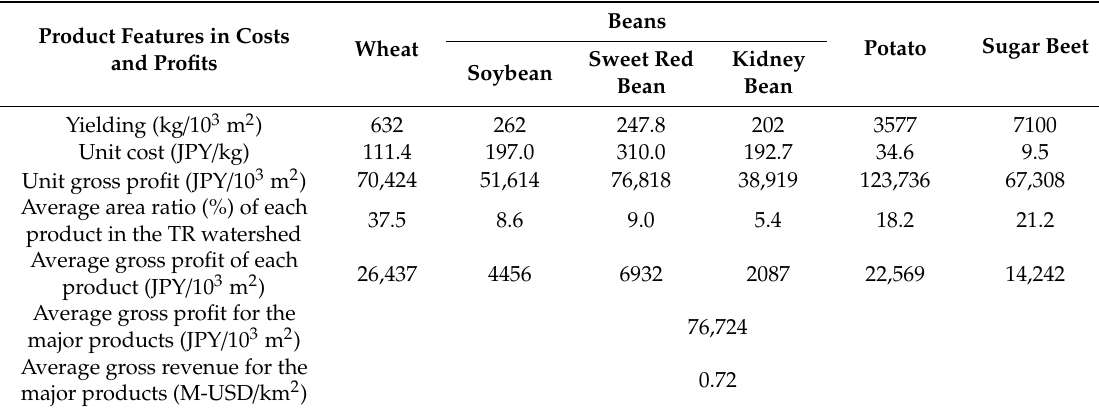
Table 4. Gross profit of the major products in the TR watershed.